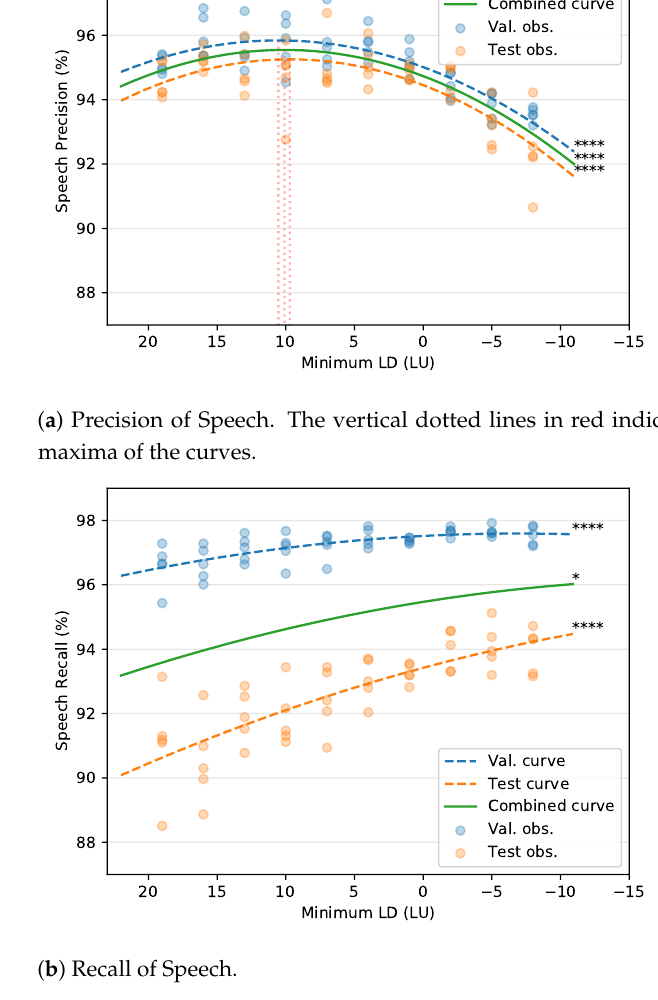
curve Test curve Combined curve Val. obs. Test obs.